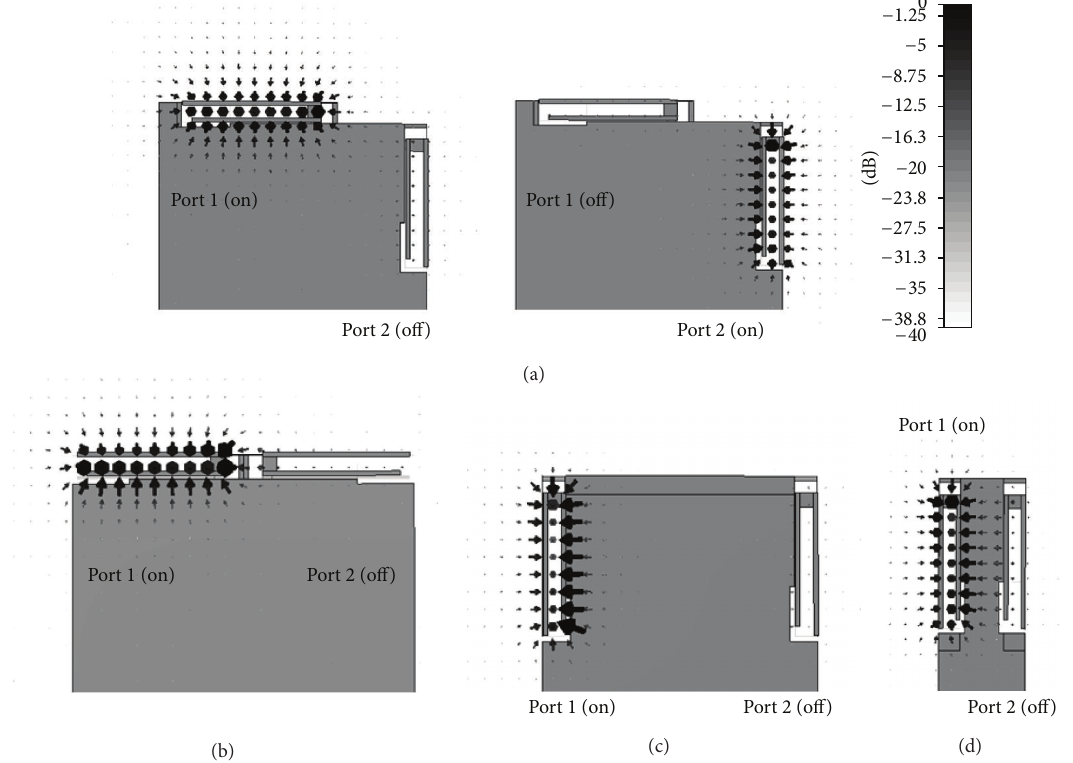
Figure 3: 𝐸 -field distribution in the near-field region; (a) case 1, (b) case 2, (c) case 3, and (d) case